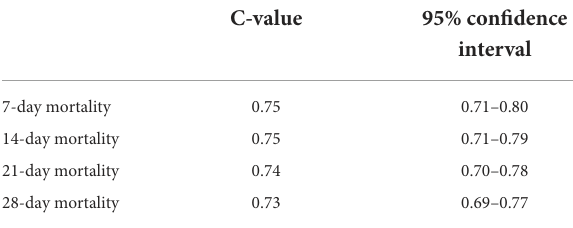
TABLE 2 AUROC analysis of risk stratification score for 7, 14, 21 and 28-day